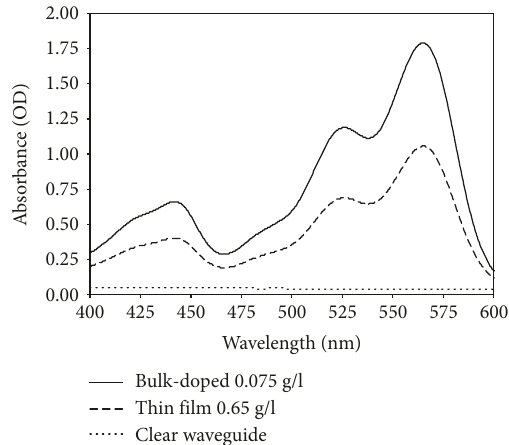
Figure 7: LSC light gains per unit exposed area during masking experiments. The thin- fi lm device was more e ff ective at collecting direct light. The bulk-doped device was more e ff ective at collecting concentrated light from the waveguide.